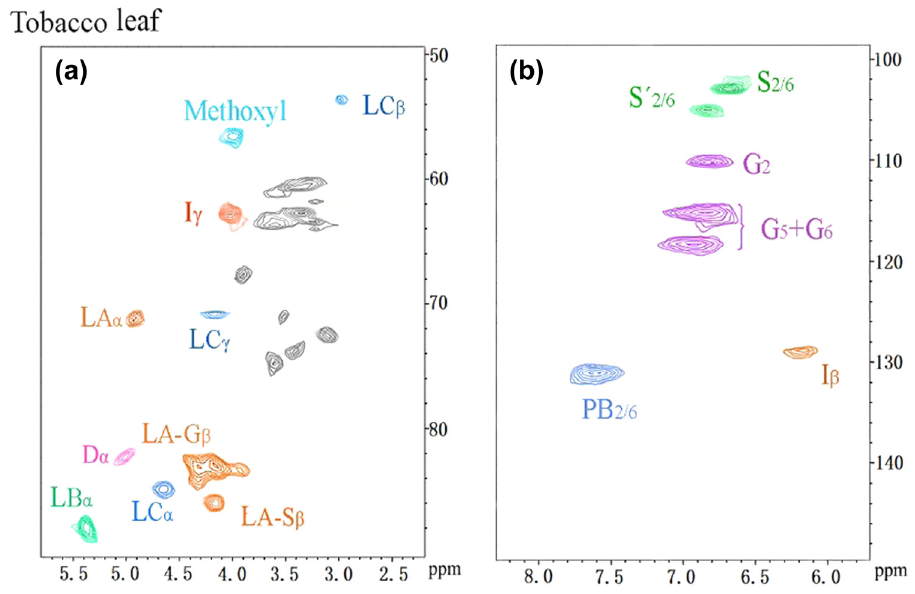
Figure 7: 2D HSQC NMR spectra of isolated lignin from tobacco leaf in DMSO - d 6 /HMPA - d 18